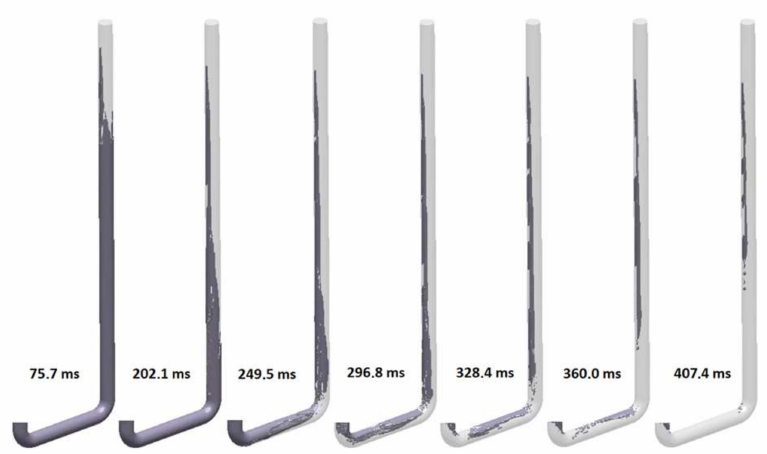
Figure 17. Air evacuation in round, non-tapered sprue (S s 1), MAGMASOFT.